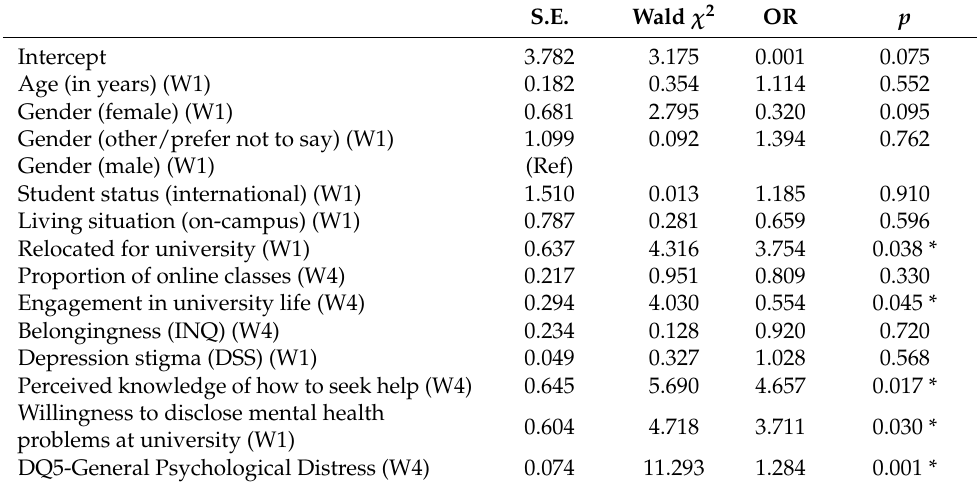
Table 4. Logistic regression model for formal help seeking behavior at Wave 4 ( N =